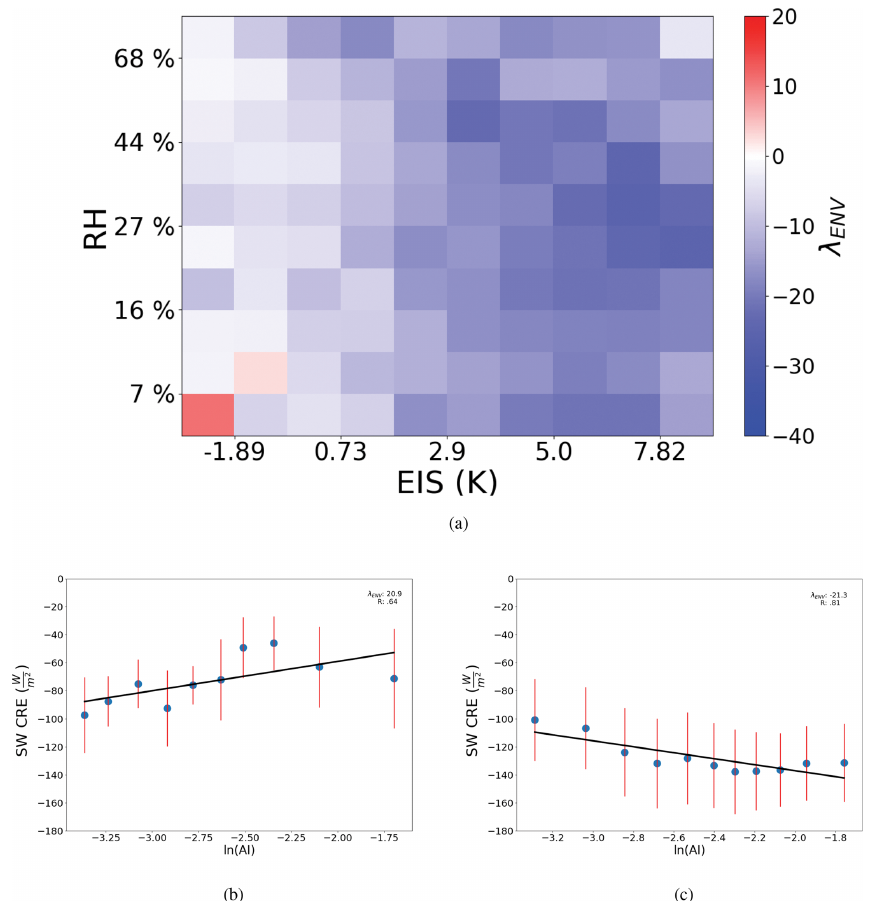
Figure 3. The sensitivity of CRE to aerosol ( λ ENV ) from Eq. (7) evaluated with constraints on the environment. When weighted and summed following Eq. (7), λ ENV is − 11 . 0Wm − 2 ln(AI) − 1 . Plots of the individual regimes from an unstable ( ∼ 1K), dry environment ( < 10% RH 700 ) (b) and stable ( ∼ 6K), moist environment ( > 30% RH 700 ) (c) , where the red lines represent the standard deviation of the SW CRE within each ln(AI) bin and the blue dots represent the mean SW CRE for each ln(AI)